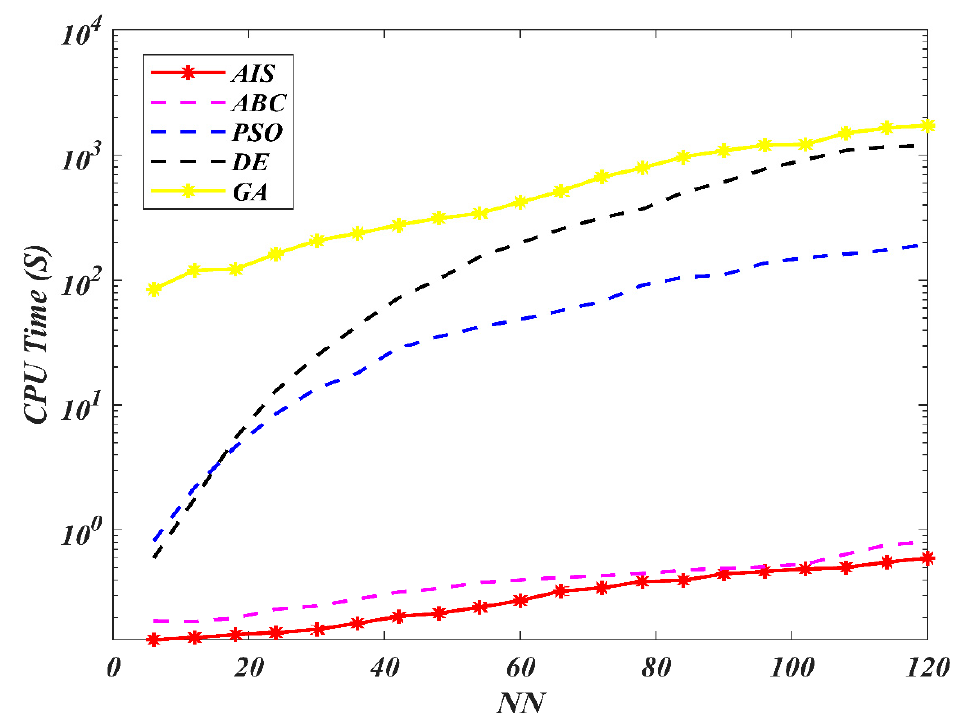
Figure 23. Central Process Unit (CPU) time Evaluation for German Credit.